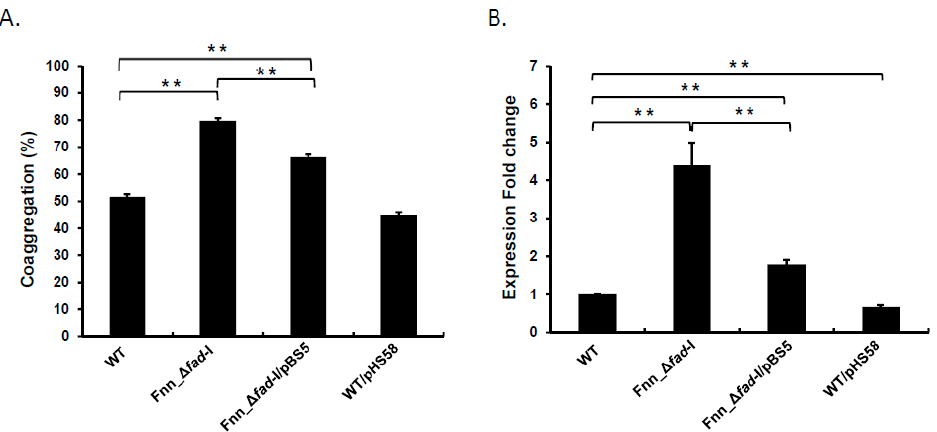
Figure 4. Characterization of the fad - I complement of F. nucleatum ssp . nucleatum. ( A ) Quantitative coaggregation of the mutant derivatives of wild-type ATCC 23726 (WT), Fnn_ Δ fad -I, and Fnn_ Δ fad - I/pBS5 with S. gordonii is shown as percentage coaggregation . ( B ) Transcriptional levels of radD in the Fnn_ Δ fad -I mutant and the Fnn_ Δ fad -I/pBS5 complement along with a vector only control WT/pHS58